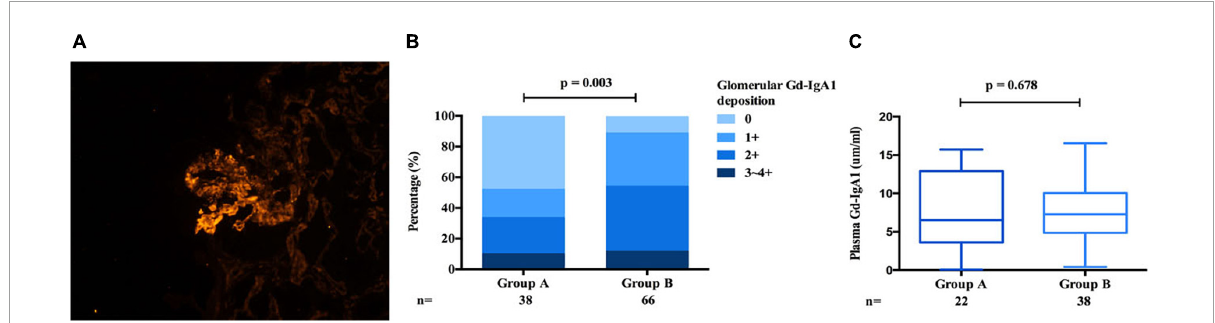
FIGURE8 Gd-IgA1 in IgAN. Granular Gd-IgA1 (KM55) by immunofluorescence along the glomerular mesangial and capillary area in patients with IgAN (A) . Gd-IgA1 mainly deposited in glomerulus and the intensity of Gd-IgA1 deposition in group B was significantly stronger than that of group A (B) . Plasma Gd-IgA1 shows no differ in group A and group B (C)